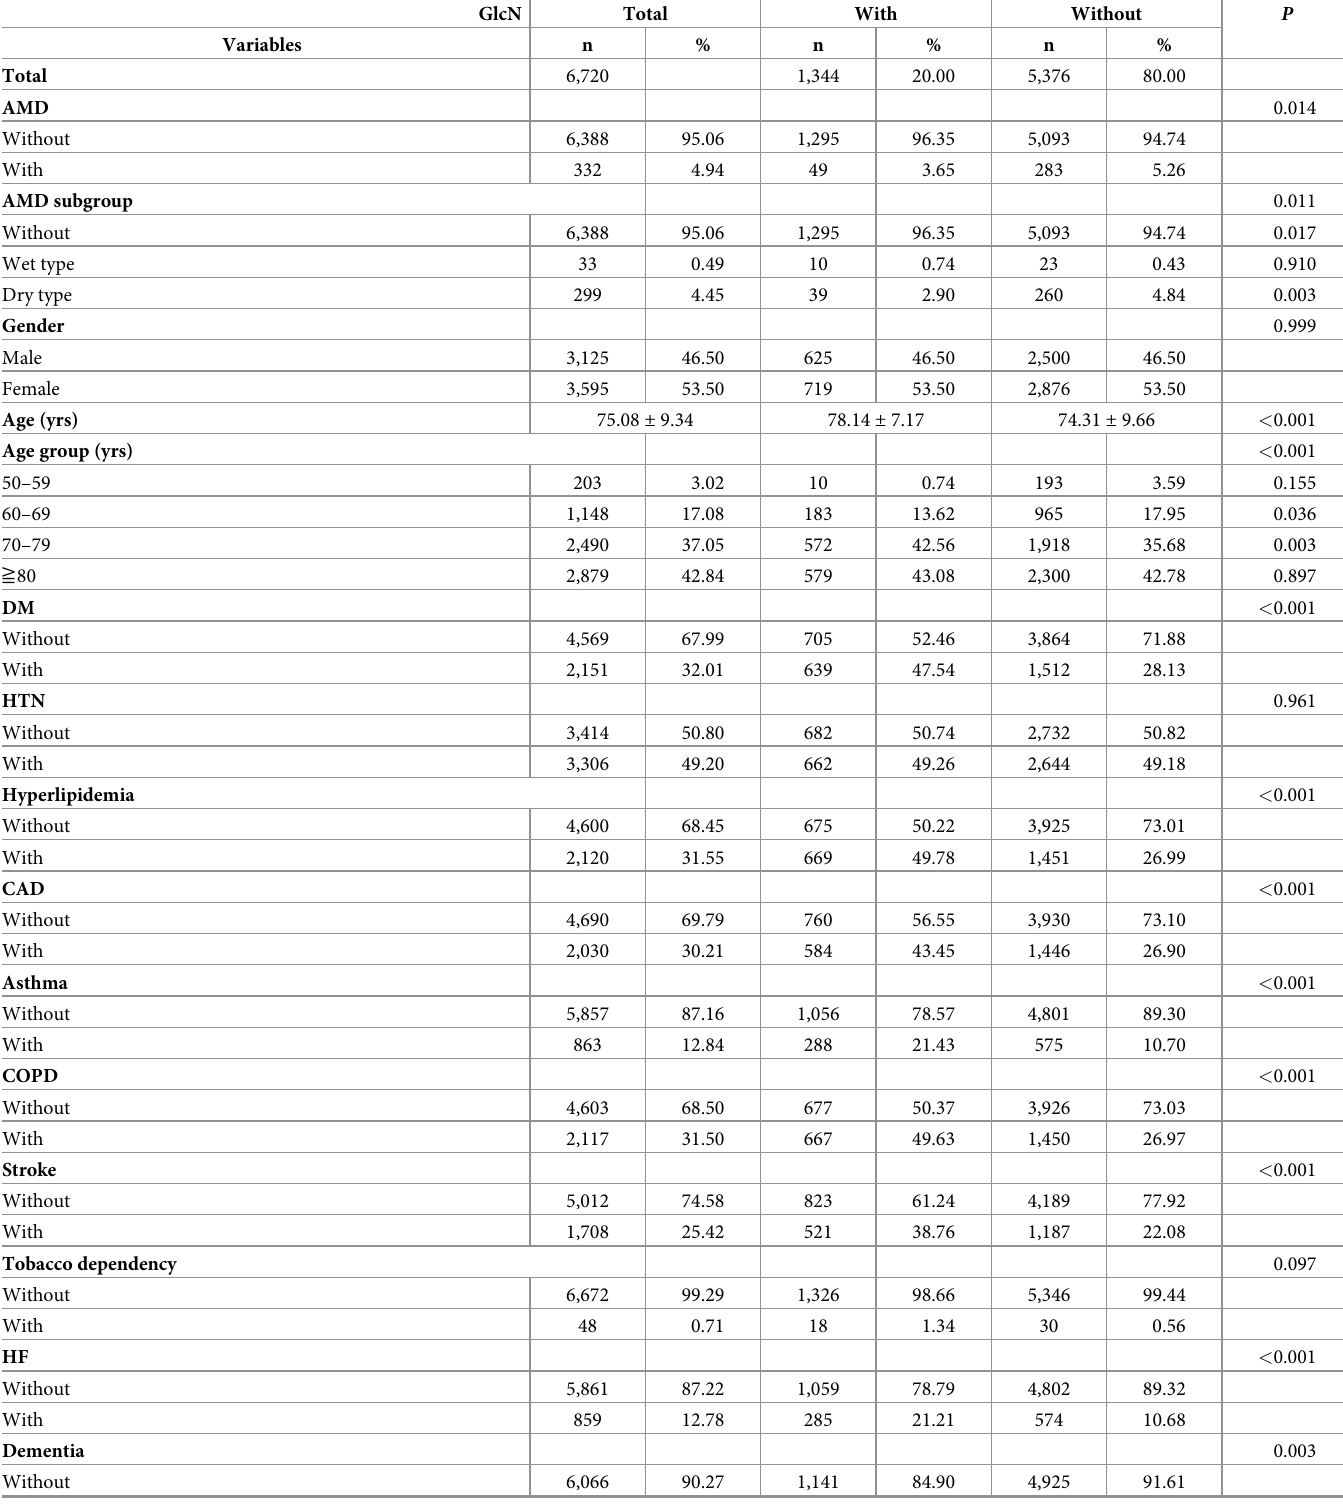
Table 1. Patient characteristics at tracking endpoint. GlcN Total With